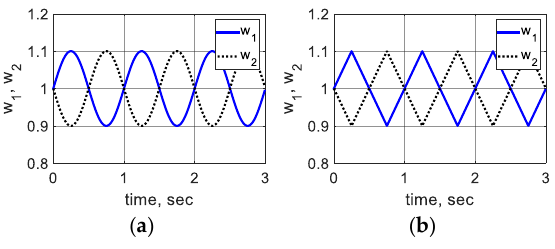
Figure 8. Examples of periodic weights: ( a ) Sinusoidal wave, ( b ) triangular wave.